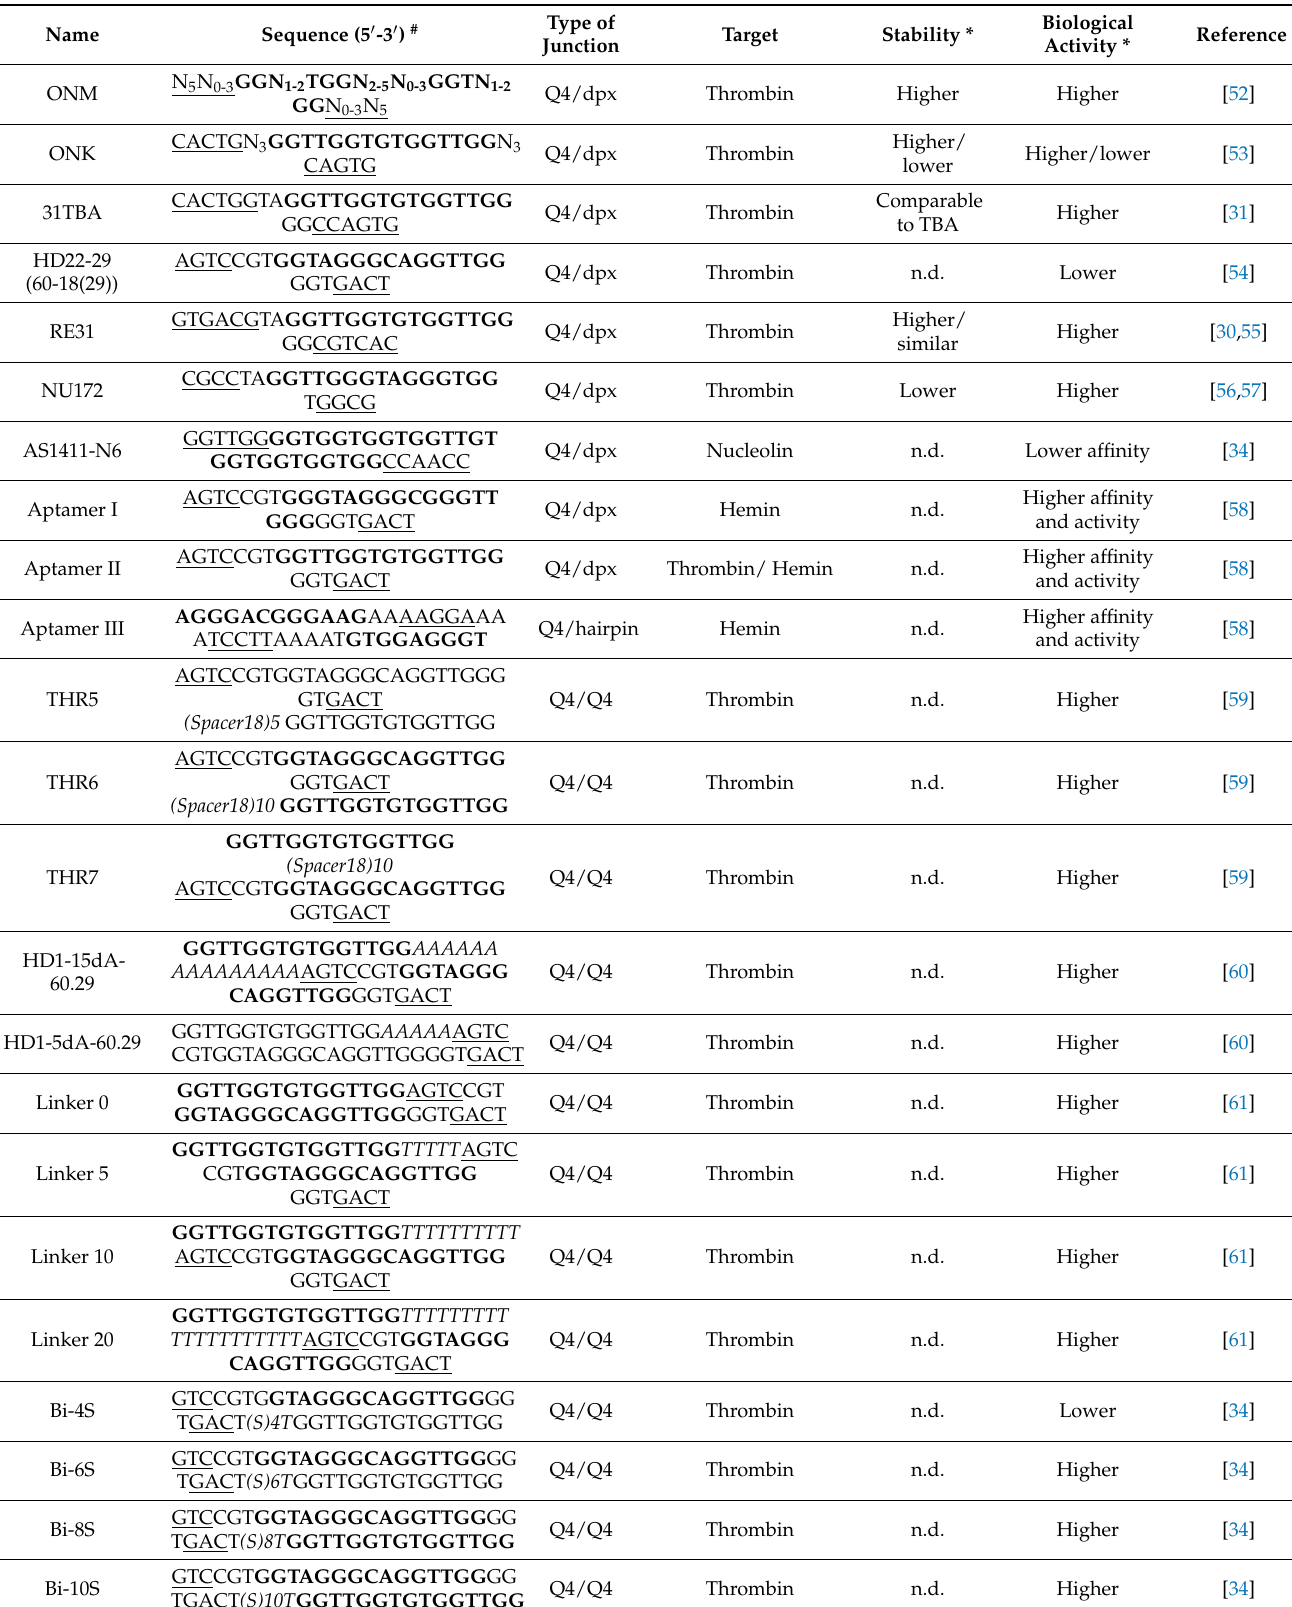
Table 1. Overview of the G-quadruplex